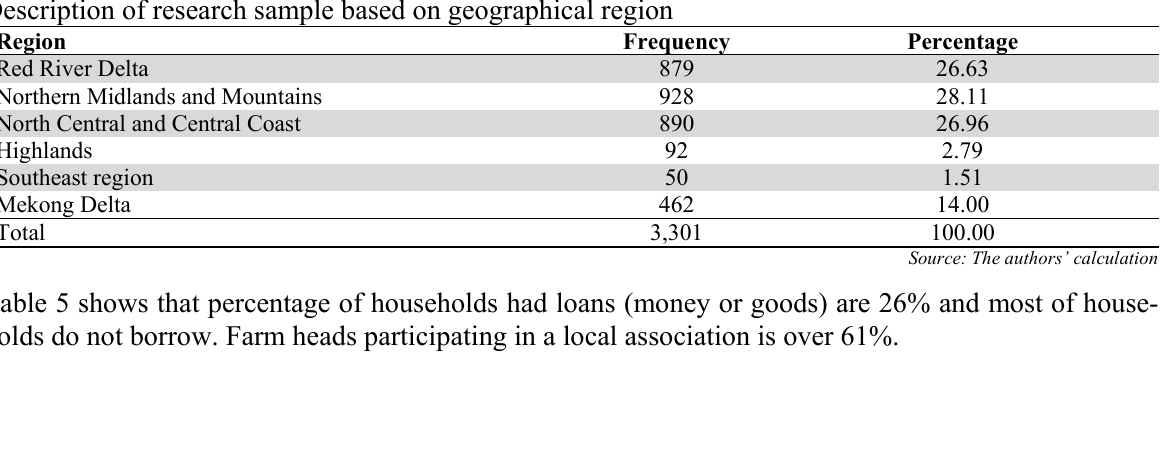
Description of research sample based on geographical region Region Frequency Percentage Red River Delta